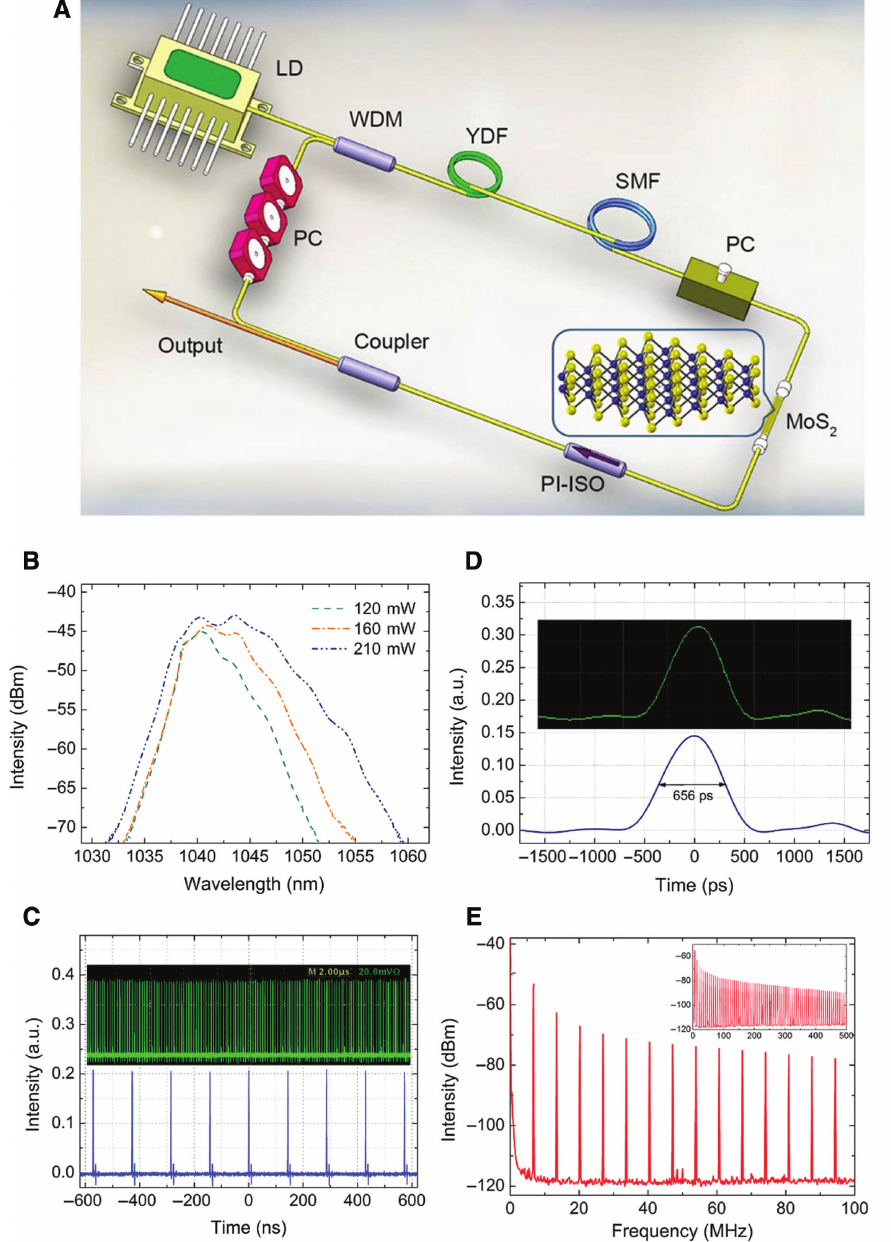
-decorated microfiber SA. Figure 4: Yb-doped mode-locked fiber laser with a MoS 2 (A) Experimental setup. (B) Optical spectra of the generated dissipative solitons under different pump powers. (C) Wide-band oscilloscope tracings. (D) Individual pulse profile. (E) Radio frequency spectral profile (inset: the wideband RF spectrum). Reproduced under the terms